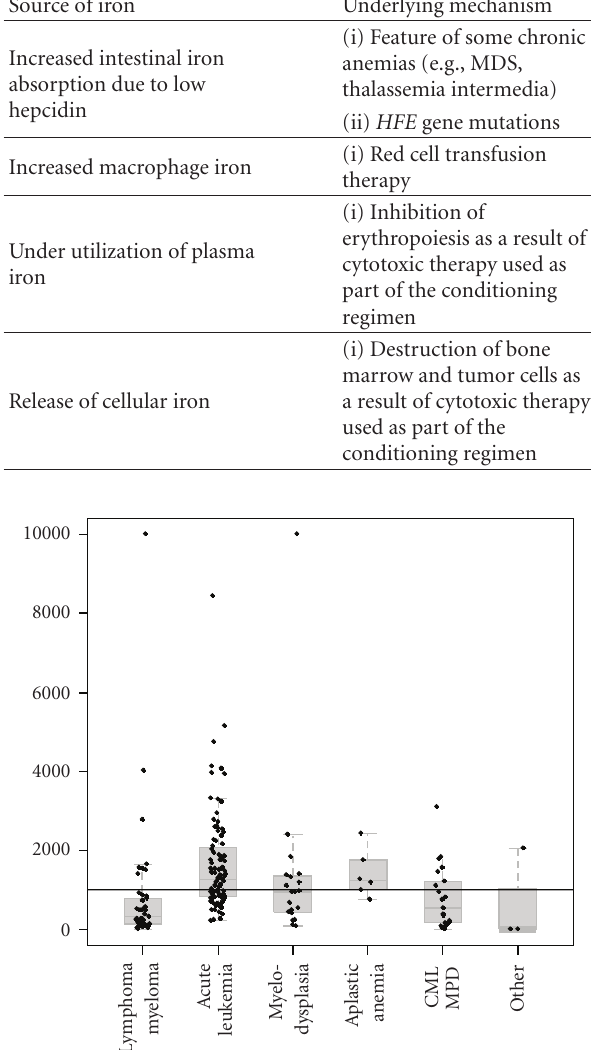
Figure 1: Iron overload in patients undergoing HSCT [8]. Dots represent individual patients, thick grey lines show median values, and the boxes indicate interquartile range. Horizontal black line represents a serum ferritin level of 1000ng/mL. CML: chronic myeloid leukemia; MPD: myeloproliferative disorder